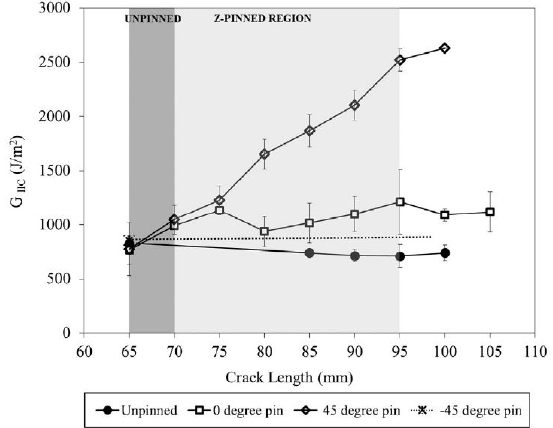
Figure 64. Effect of z-Pin offset angle on mode II apparent fracture toughness of z-Pinned laminate = 0.28 mm, [0 / 45 / 90 / -45] (CFRP z-Pins, 0.4 vol%, d = 0.28 mm, [0/45/90/-45] 4s pre-preg) [17]. (CFRP z-Pins, 0.4 vol%, d 4s pre-preg)